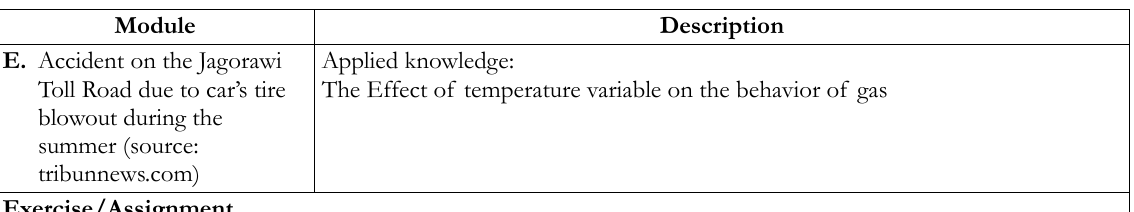
Table 3. The overview of case study-based module